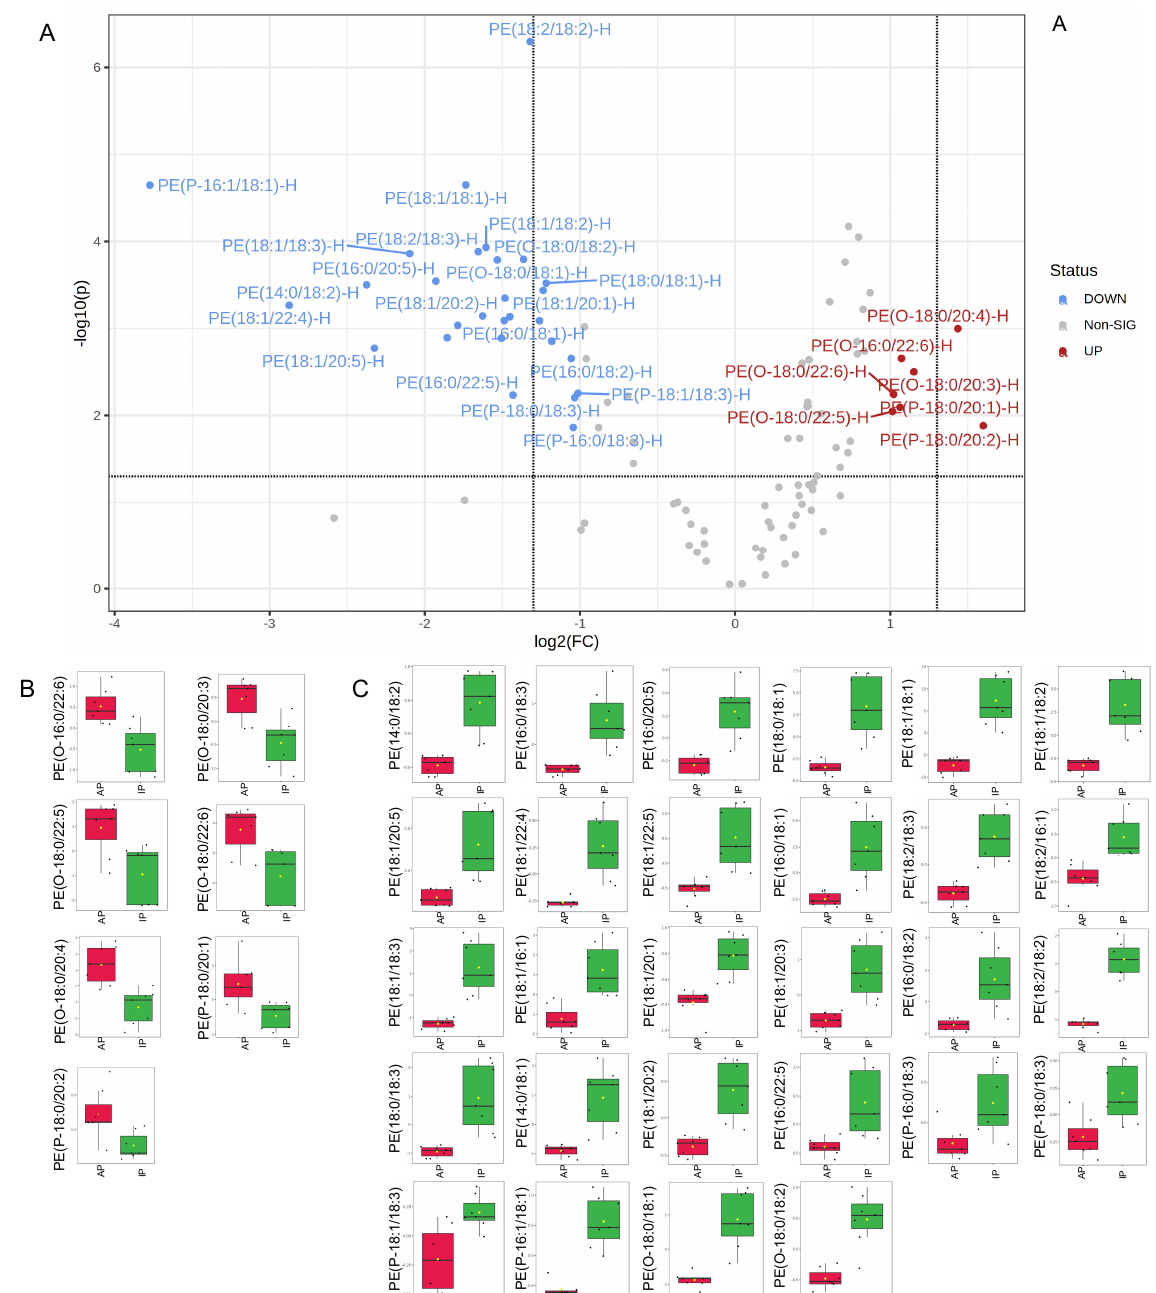
Figure 4. Phosphatidylethanolamine levels in uEVs isolated from urine collected during the inactive and active phases of spontaneously hypertensive aged male mice. ( A ) Volcano plot showing all PE’s increased or decreased in the EVs from the active phase (AP) group compared to the inactive phase (IP) group and all other PE’s that did not show a statistically significant difference between the two groups. The fold change threshold was set to 2.0 and the p -value threshold was set to 0.05. Data were normalized to the median with Pareto scaling and the plots were made in MetaboAnalyst software. ( B ) Normalized plots showing 7 PE’s that are significantly increased in EVs isolated from urine samples collected during the AP compared to the IP. ( C ) Normalized plots showing 28 PE’s that are significantly decreased in EVs from the AP group compared to the IP group. n = 7 samples per group. EVs isolated from AP urine are in red and EVs isolated from IP urine are in green. The concentration of each lipid on the y -axis is given in µ